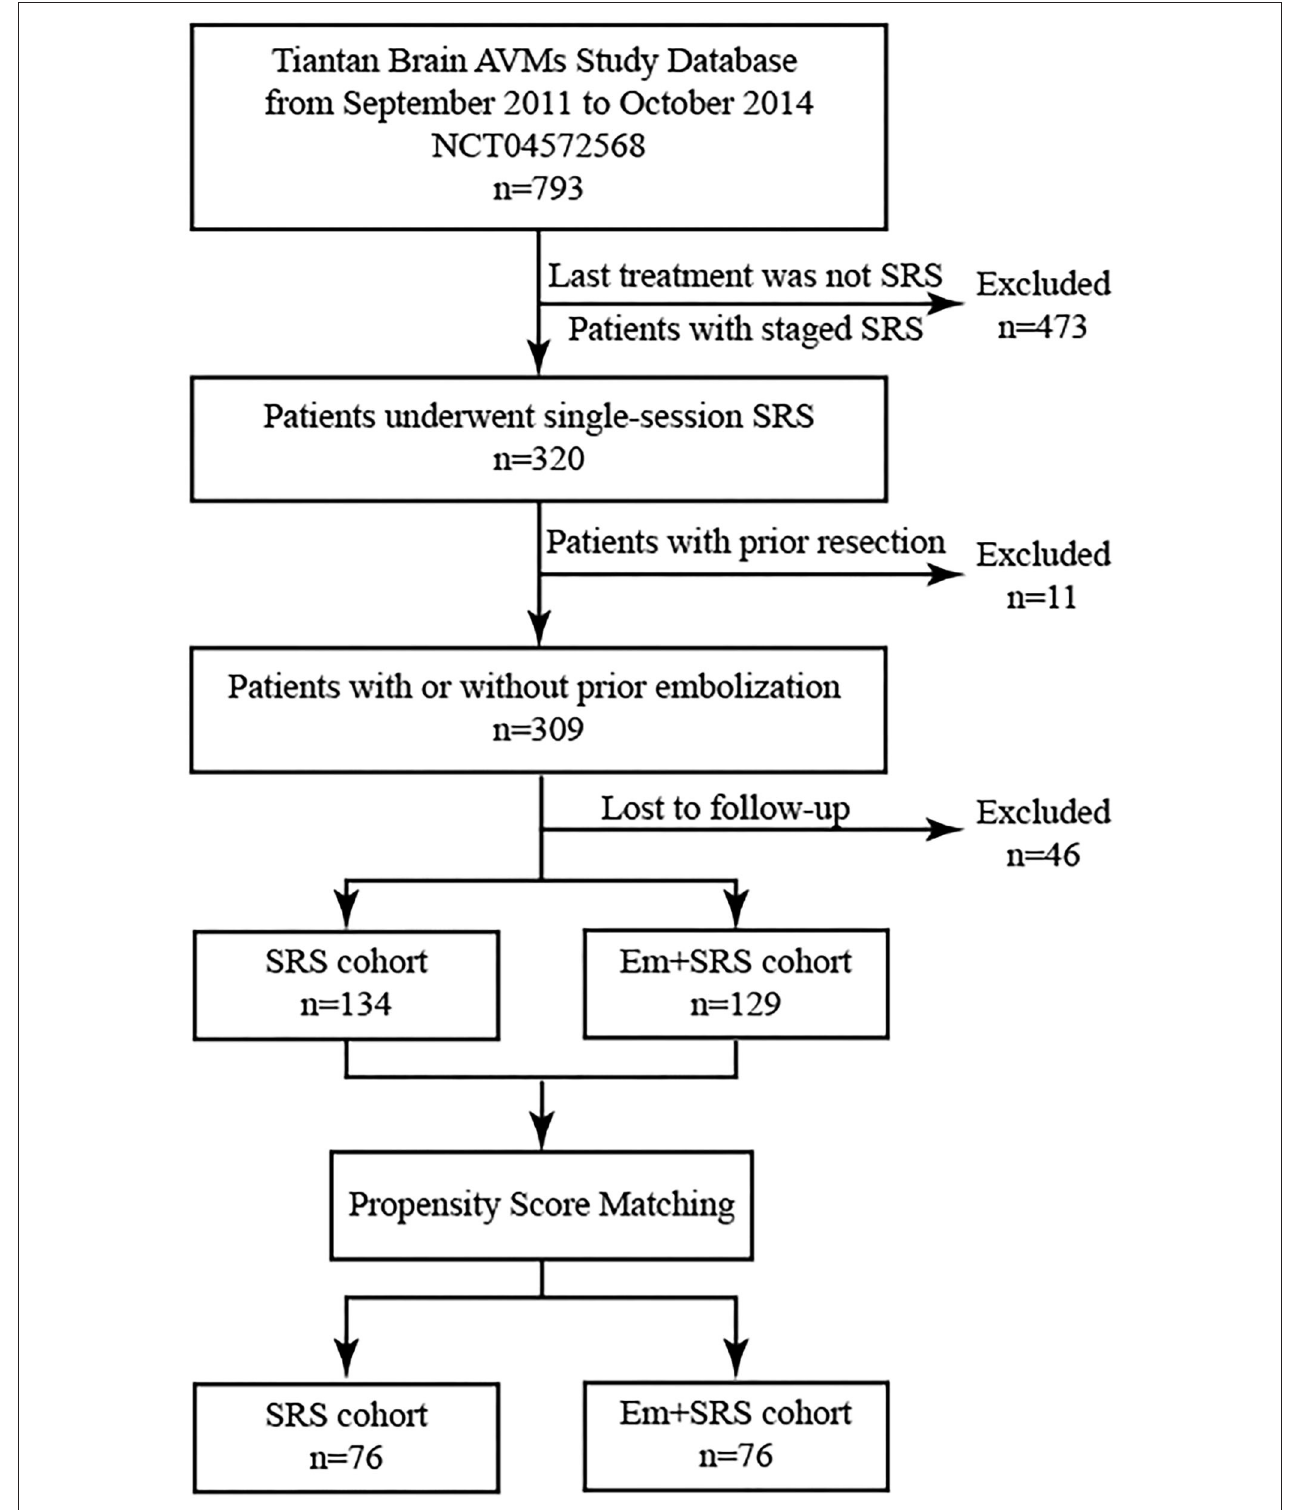
FIGURE 1 | Patient flowchart demonstrating patient selection and propensity score matching (PSM) process. AVM, arteriovenous malformation; SRS, stereotactic radiosurgery; Em + SRS, prior embolization to stereotactic radiosurgery.